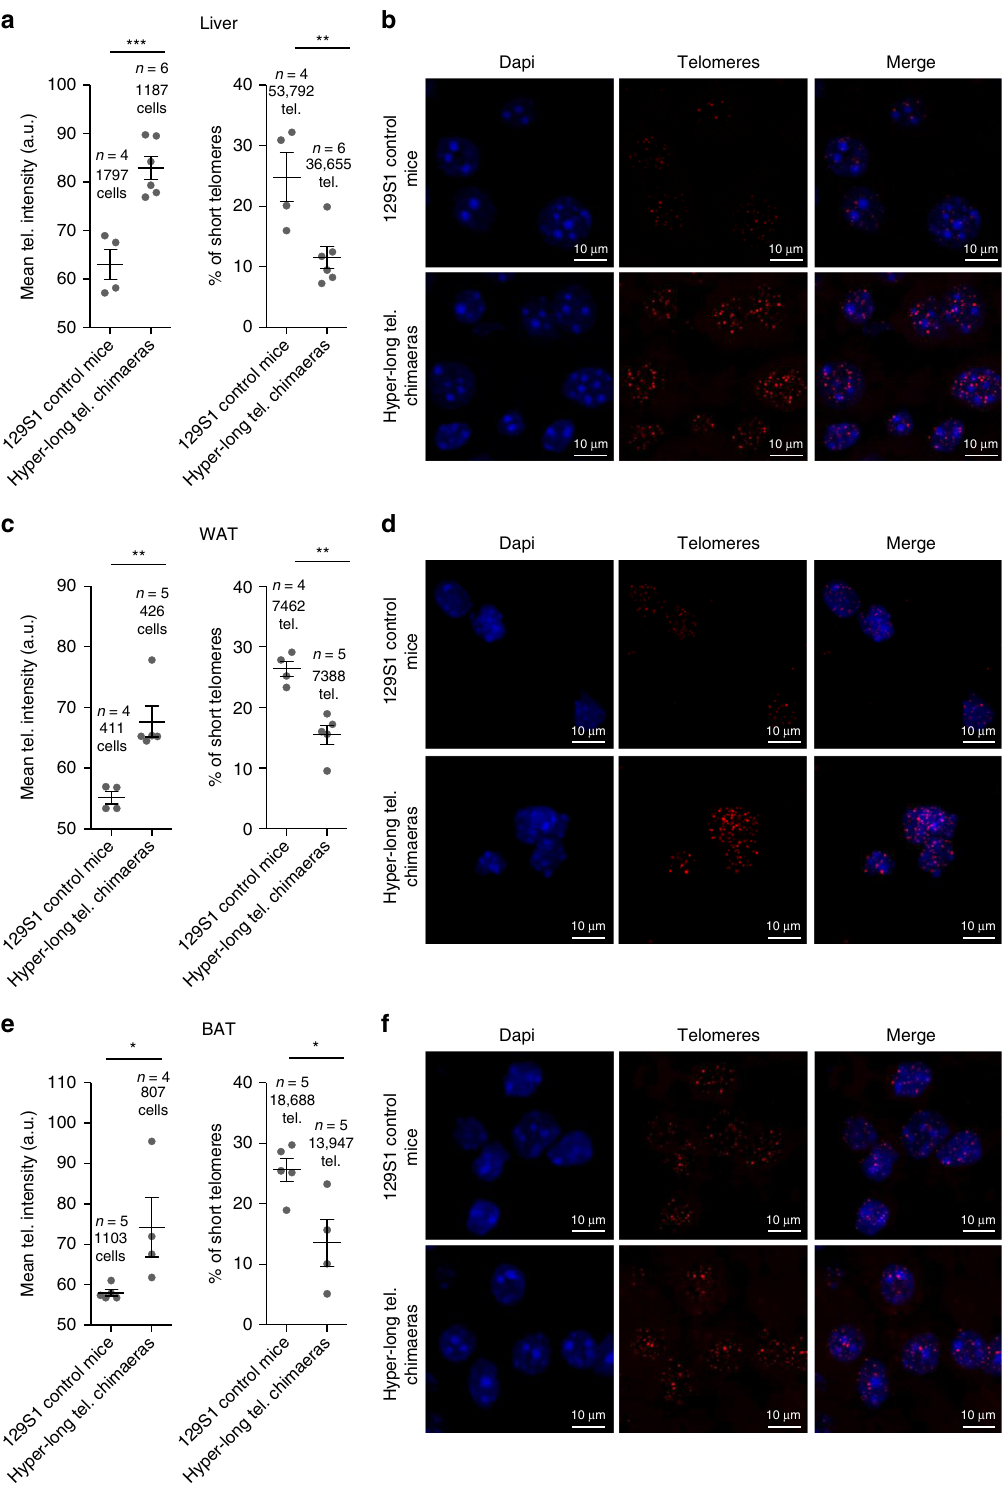
Fig. 6 Hyper-long telomere mice show longer telomeres throughout their lifespan in metabolic-related tissues. a – f Mean telomere fl uorescence and percentage of short telomeres in liver ( a , b ), white adipose tissue ( c , d ) and brown adipose tissue ( e , f ), in 100 weeks-old hyper-long telomere mice and age-matched controls. Error bars represent standard error. t -test was used for statistical analysis. The number of mice is indicated in each case. * p < 0.05. ** p < 0,01. *** p < 0,001. Source data are provided as a Source Data fi